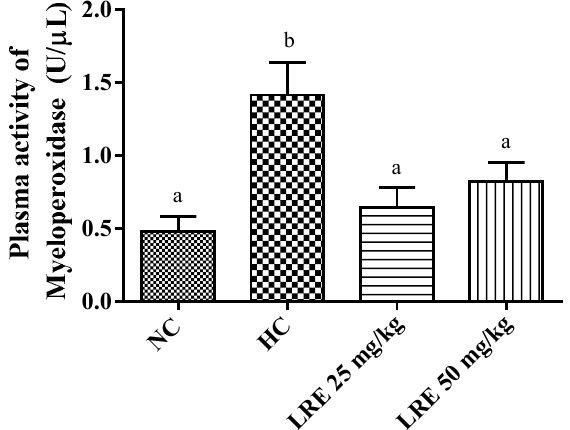
Figure 6. Plasma concentration of myeloperoxidase (MPO) of hamsters submitted to experimentally induced dyslipidemia and treated with LRE. Each column represents Mean ± SEM (standard error of the mean) of 7–9 animals/group. Two mean values that are not indicated with the same letter are significantly different from each other ( p < 0.05). One-way ANOVA followed by Tukey’s test.